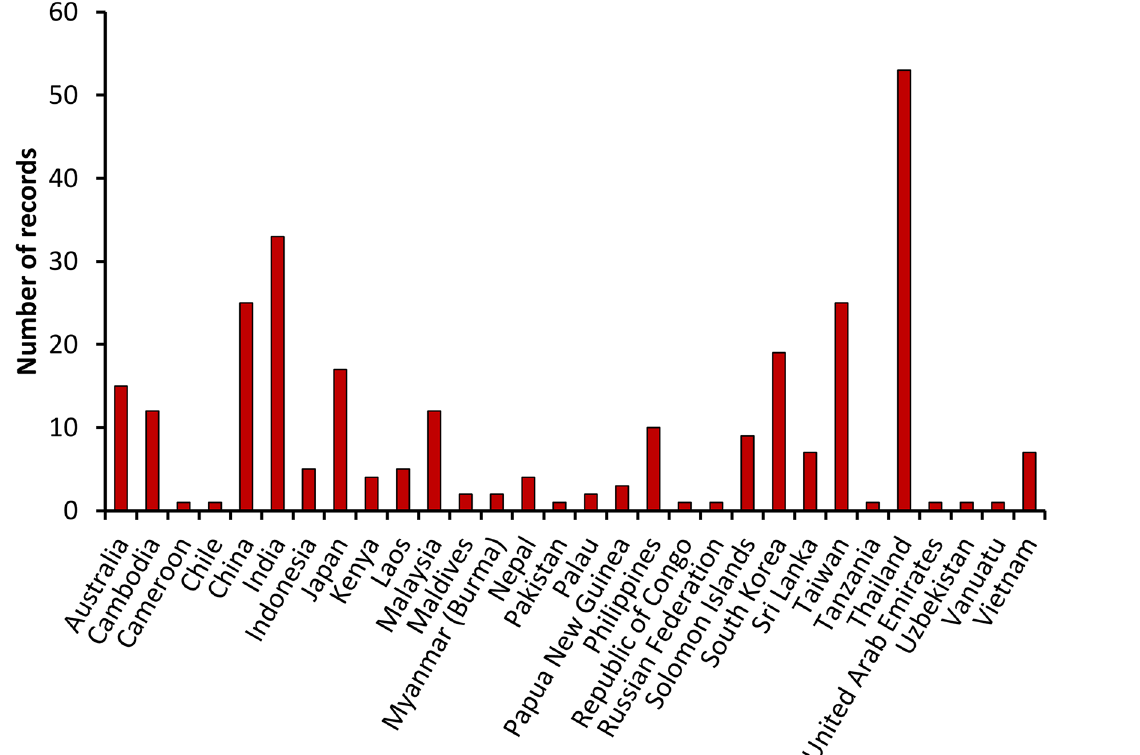
Fig 3. Frequency of report records of scrub typhus cases as reported by